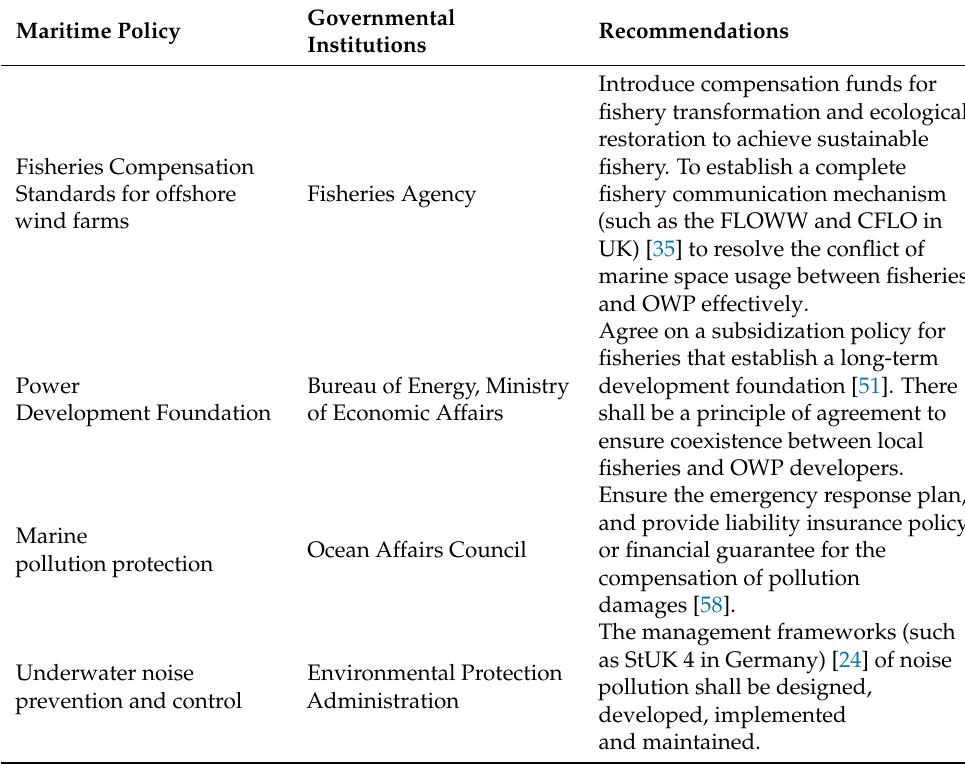
Table 2. Recommendations to achieve the objectives of coexistence between fisheries and green energy generation in